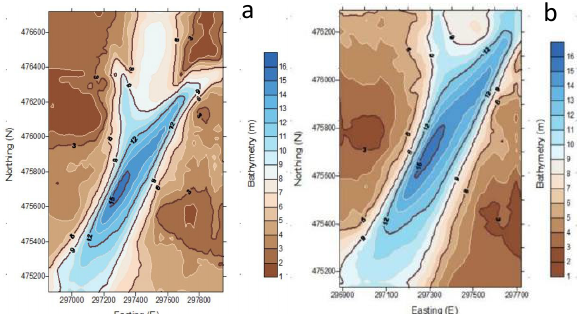
Figure 23. The bathymetric plan generated using Surfer in 2D. a) The bathymetric plan in 2017 and b) the bathymetric plan in